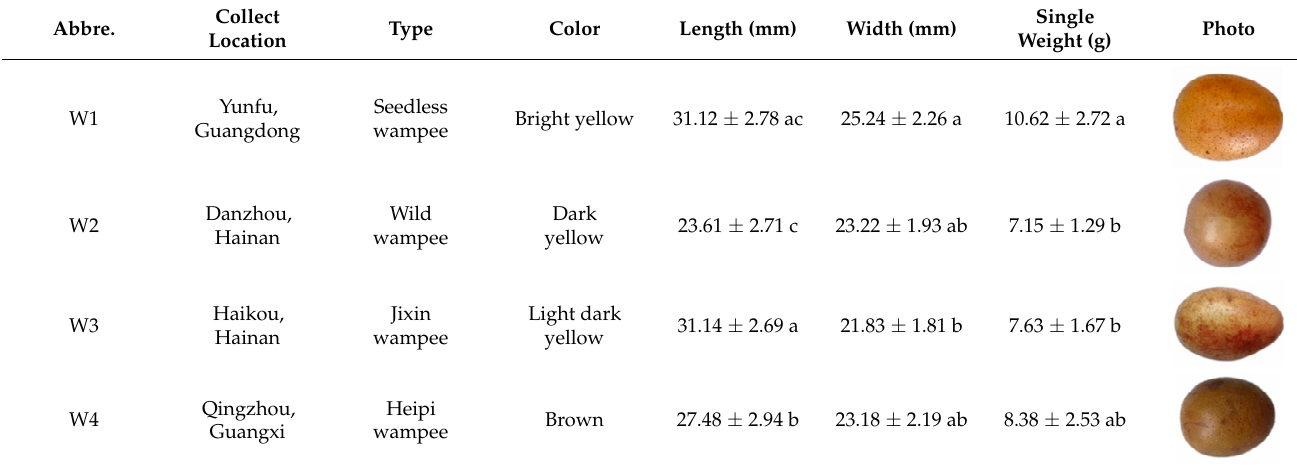
Table 1. Species information of the four wampee samples from South China (n = 6). Abbre.